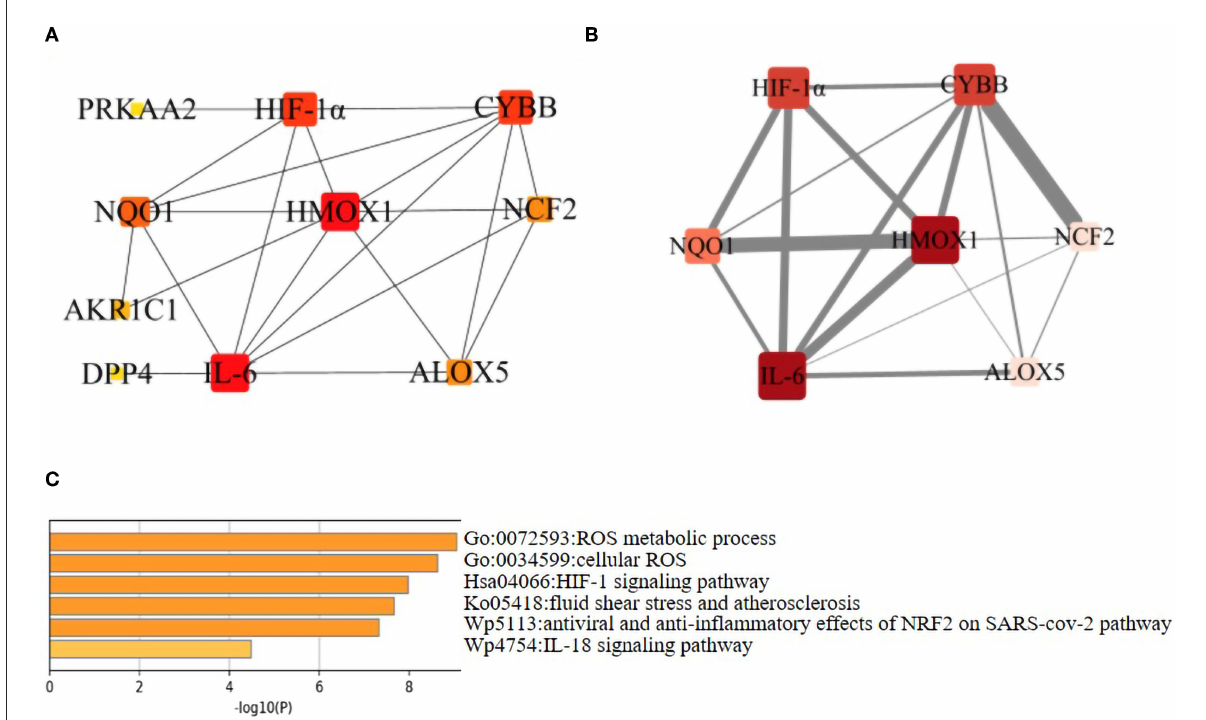
FIGURE4 Network analysis of ferroptosis DEGs. (A) PPI network of the ferroptosis DEGs. Visualization of PPI networks containing 11 nodes and 22 edges was obtained with interaction scores > 0.4. Ten of the 21 genes did not form a molecular network with other molecules (not shown). (B) PPI network of the key ferroptosis DEGs. The key module was identified by the Cytokeyba plug-in of Cytoscape software for clustering analysis of the key gene network. The node gene cluster with the highest score constructed by the MCODE plug-in in Cytoscape consists of seven genes. Genes were represented by nodes (the size of nodes referred to the degree, the color depth of nodes referred to the neighborhood connectivity, i.e., closeness), and links between genes were represented by edges (the thickness of gray edges referred to a combined score ranging from 3.2 to 4.0). (C) Functional enrichment analysis of seven key ferroptosis DEGs. It was shown that the HIF-1 signaling pathway was significantly enriched. These six biological pathways were drawn based on the p -value ( < 0.0001) and the percentage of the gene